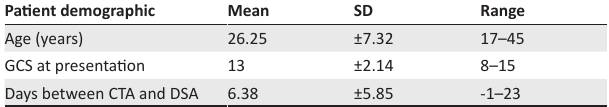
TABLE 3: Summary of data from patient cohort.